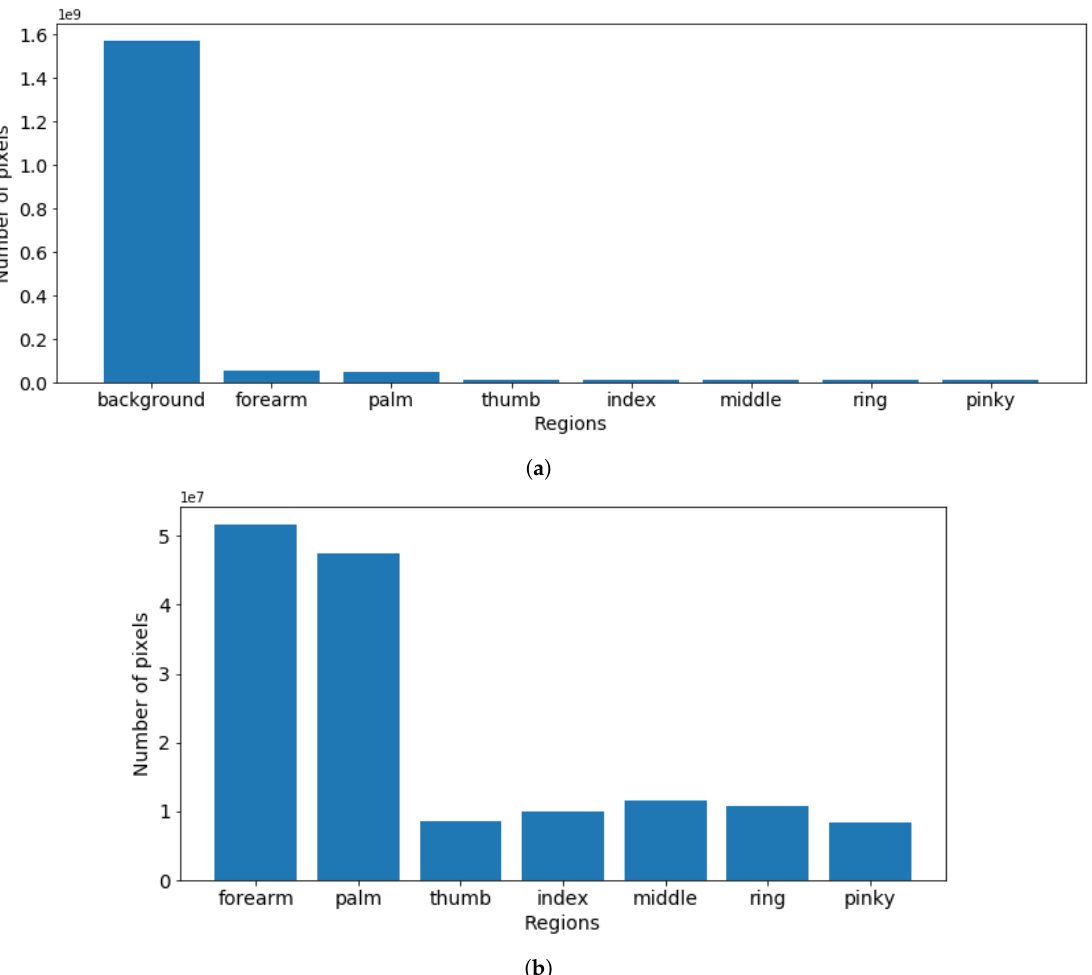
Figure 10. Number of pixels of the regions in the FingerPaint dataset on all regions ( a ) and regions without the background ( b